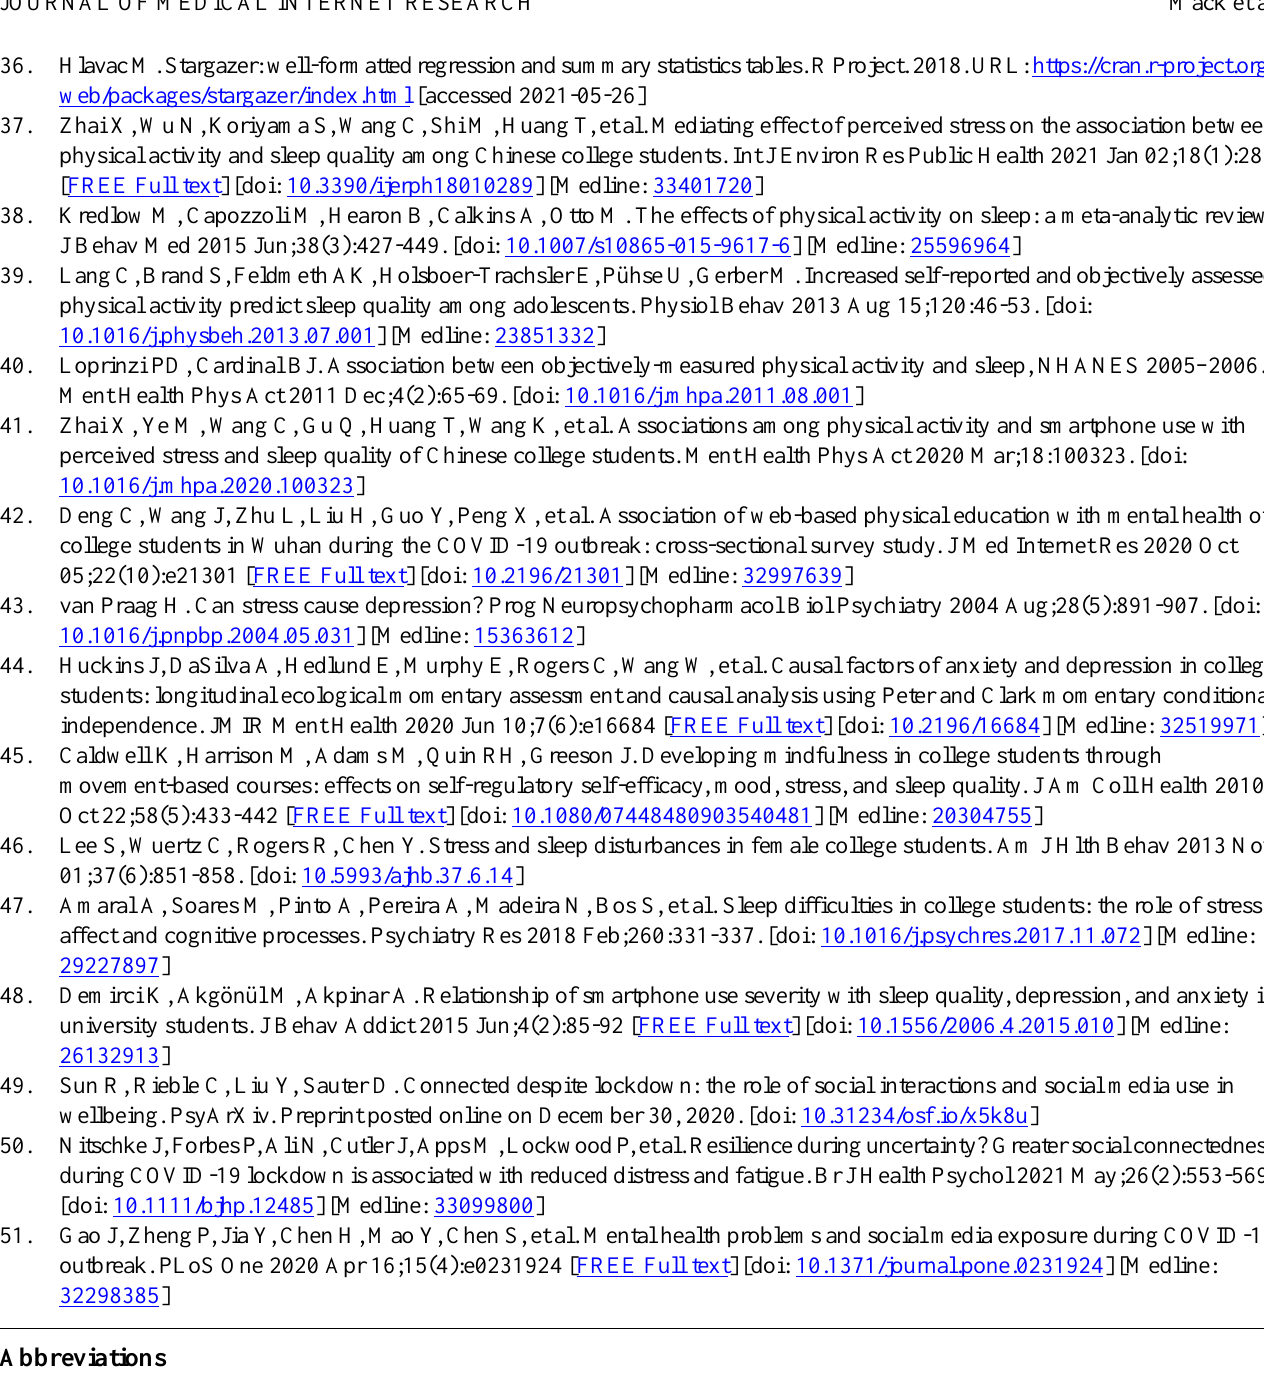
DBSCAN: density-based spatial clustering of applications with noise EMA: ecological momentary assessment GAD-2: Generalized Anxiety Disorder-2 PHQ-2: Patient Health Questionnaire-2 PHQ-4: Patient Health Questionnaire-4 WHO: World Health